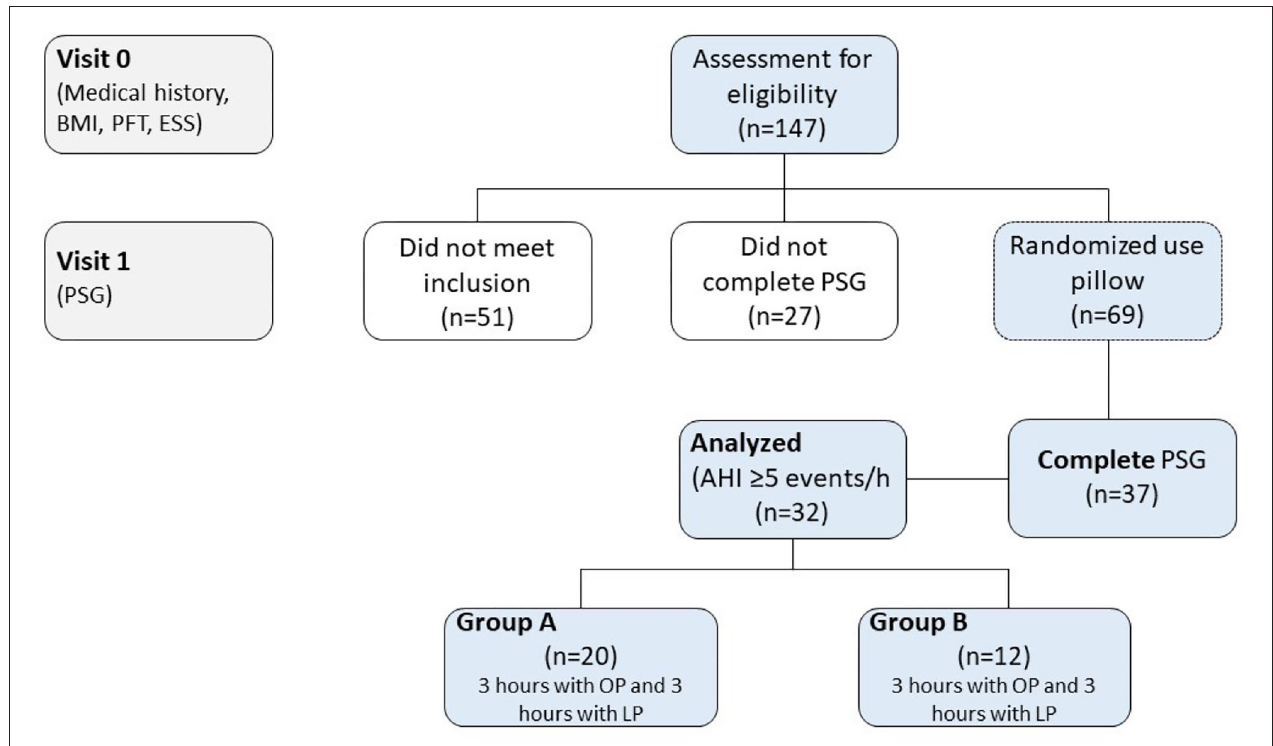
FIGURE 1 | Study flow diagram. BMI, body mass index; ESS, Epworth sleepiness scale; LP, laboratory pillow; MFP, memory foam pillow; OP, own-pillow; PFT, pulmonary function test; PSG, polysomnography study.